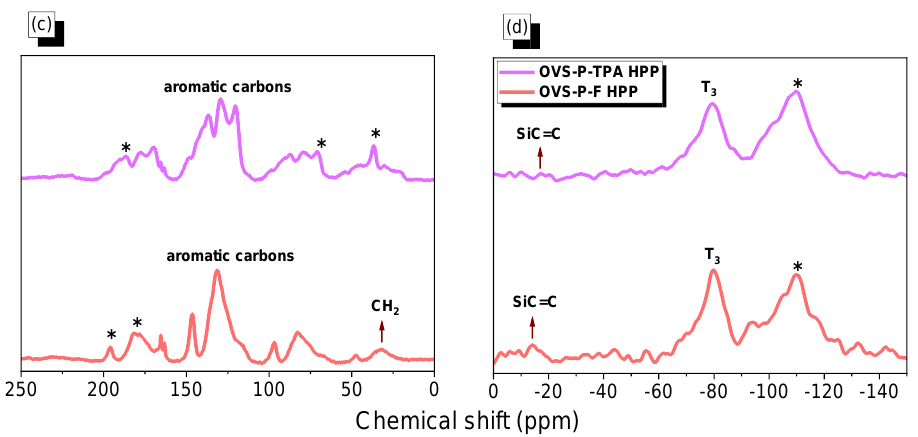
Figure 1. FTIR analyses of ( a ) OVS, P-Br 4 , TPA-Br 3 , and OVS-P-TPA HPP; ( b ) OVS, P-Br 4 , F-Br 2 , and OVS-P-F HPP; ( c ) the 13 C NMR solid-state profile; and ( d ) the 29 Si NMR solid-state profile of OVS-P-TPA HPP and OVS-P-F HPP. * denotes the side band of solid-state nuclear magnetic resonance spectroscopy (NMR).